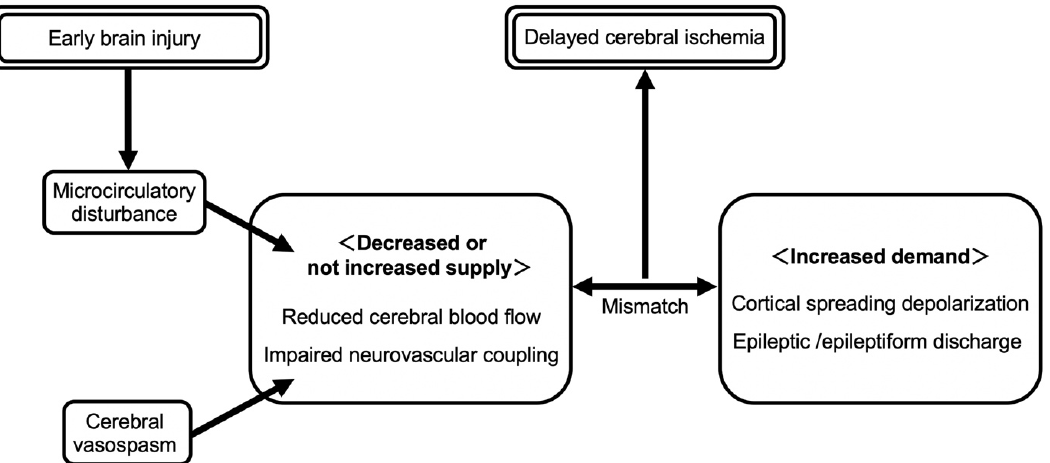
Figure 3. Metabolic supply-demand mismatch hypothesis for delayed cerebral ischemia. When metabolic demand is increased due to depolarizing events such as cortical spreading depolarizations or epileptiform activities and exceeds the impaired blood supply (decreased blood supply or not sufficiently increased blood supply) due to large-vessel vasospasm or microcirculatory disturbance after subarachnoid hemorrhage, a mismatch in neuronal metabolism occurs, resulting in relative cerebral ischemia, that is, delayed cerebral ischemia.